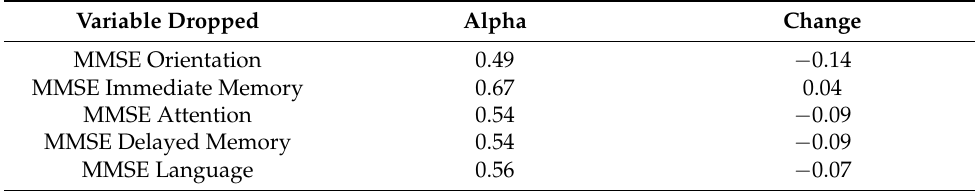
Table 2. Cronbach’s alpha—dropping variables.